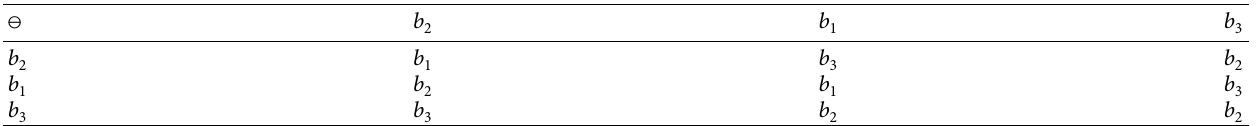
Table 5: Composition of C under the rule ⊖ .